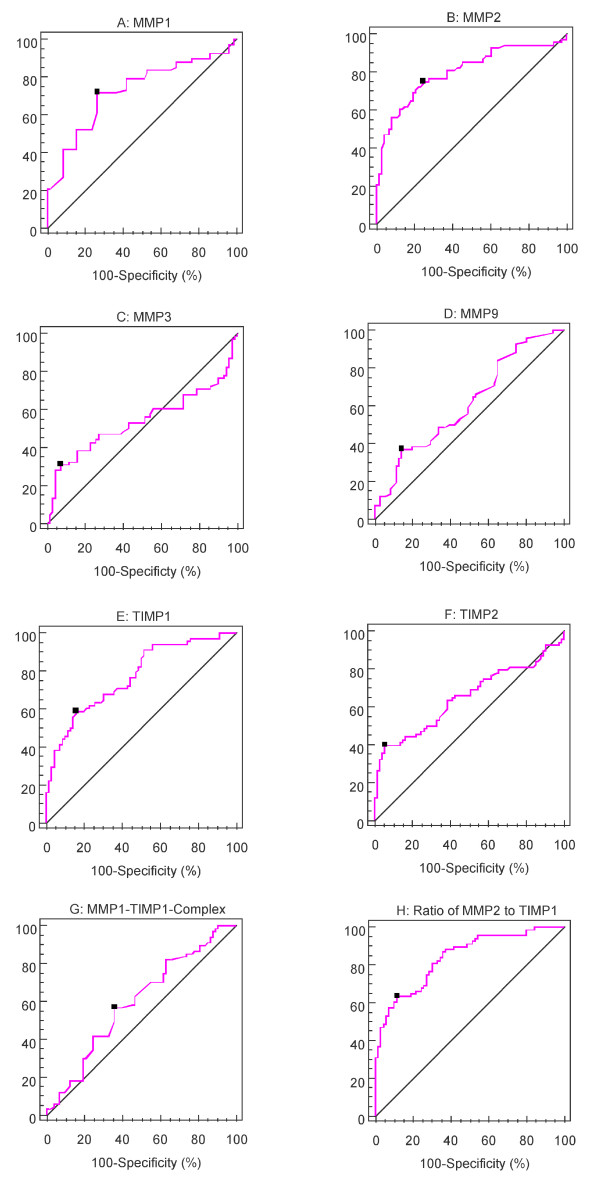
A-H. ROC curves for MMP1, MMP2, MMP3, MMP9, TIMP1, TIMP2, MMP1/TIMP1-complex, and the ratio of MMP2 to TIMP1 from bladder cancer patients. The healthy controls are included. AUCs are given in Table 2. MMP2 showed the largest, MMP3 the highest AUC. The cutoff point (black square box) in each curve indicates the point with the highest diagnostic accuracy.